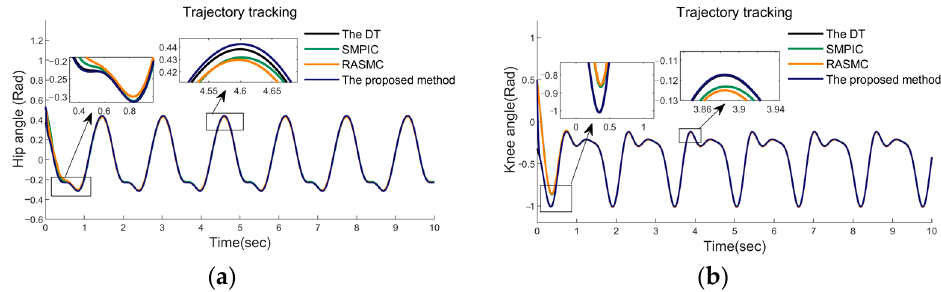
Figure 12. The tracking response of the joints. ( a ) the response of θ 1 under case 2 condition; ( b ) the response of θ 2 under case 2 condition.